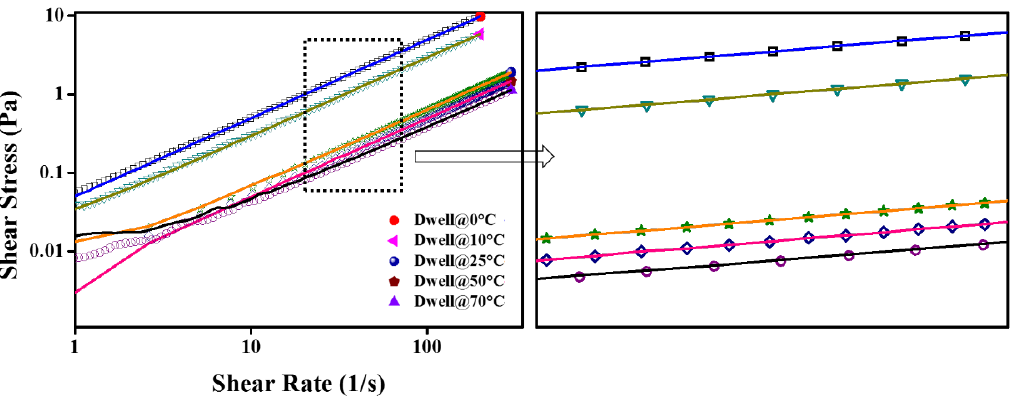
Figure 15. Hysteresis loop test for NF1; the bullets represent an upward curve while solid lines show downward.